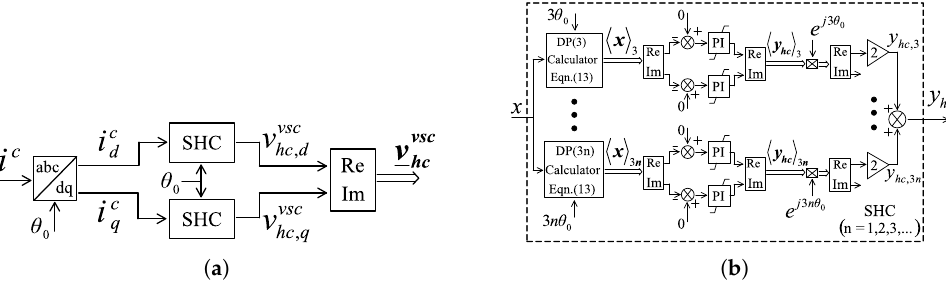
Figure 5. Harmonic compensation (HC): ( a ) the HC scheme; ( b ) the selective harmonic compensation (SHC)